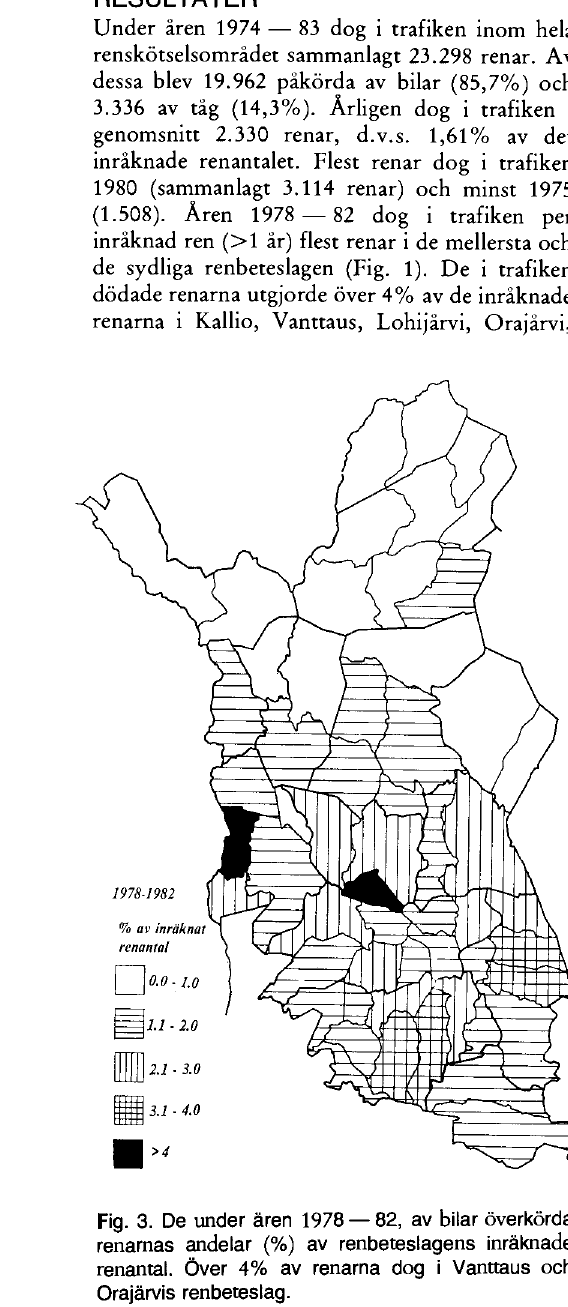
Fig. 3. De under åren 1978 — 82, av bilar overkorda renarnas andelar (%) av renbeteslagens inråknade